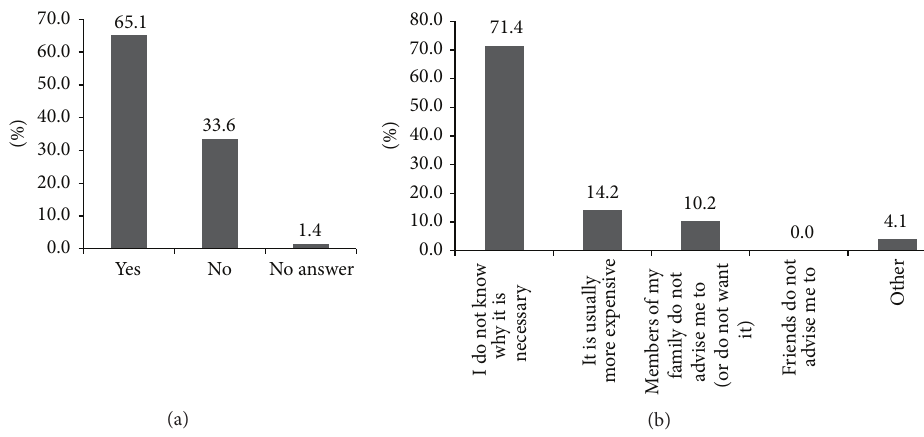
Figure 5: Using status of iodized salt (a) and the reasons of not using iodized salt